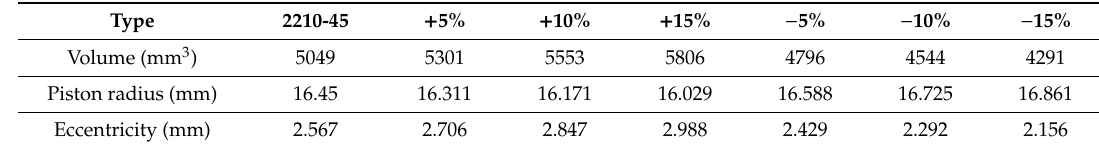
Table 4. Di ff erent working volumes of compressor. Table 4. Different working volumes of compressor.